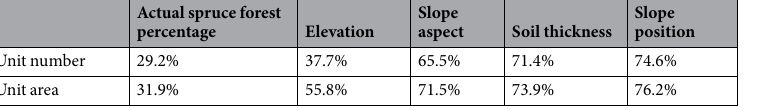
Table 3. The accumulated prediction accuracy of the distribution of Qinghai spruce forests (and non-forest vegetation) by considering the limiting